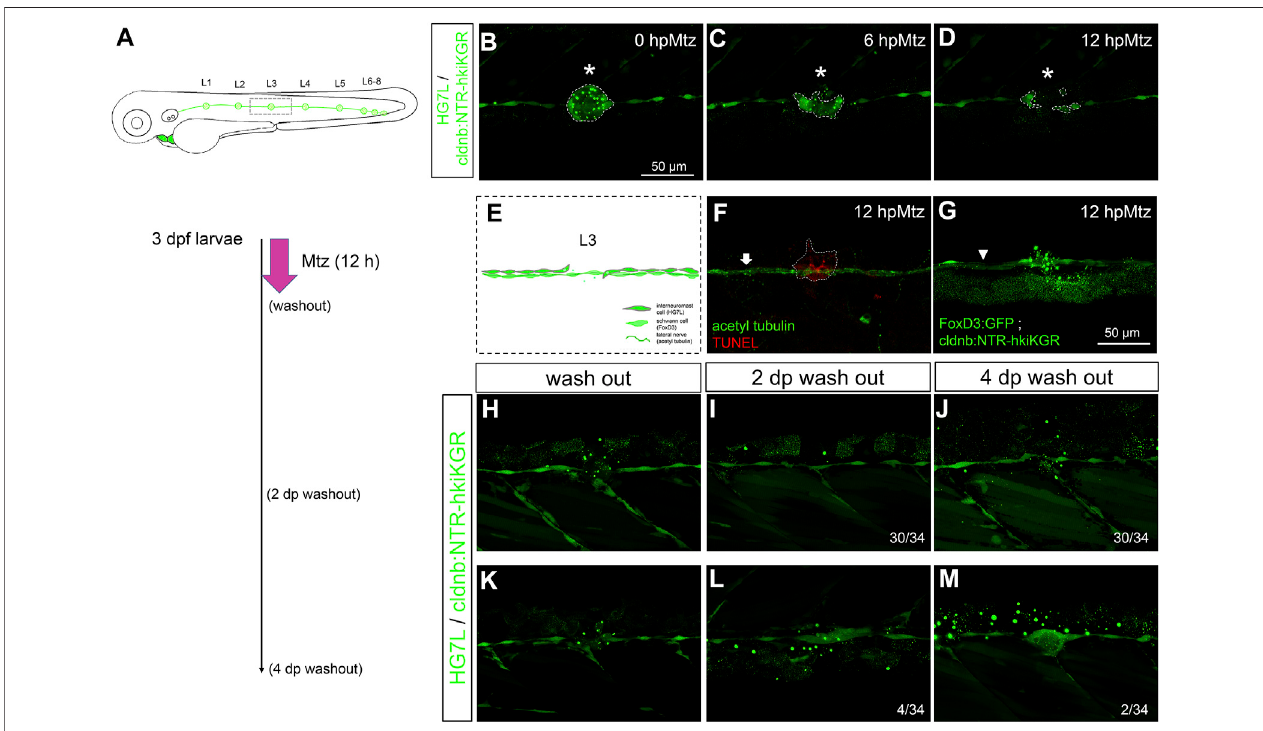
FIGURE 5 | Chemical-genetic ablation of neuromasts blocks neuromast regeneration in most but not all larvae. (A) Larvae from the cross of Et(HG7L) (green) and Tg( − 8.0cldnb:NTR-hkiKGR) (green dots) were treated with 2 mM metronidazole (Mtz) ob 3 days post-fertilization (dpf) for 12 h, washed out, cultured, examined, and photographed at designated h post-Mtz treatment (hpMtz) as shown in a series of cartoons. (B – D) Representative stacked images show decreasing size (enclosed by dashed lines) of neuromast (asterisks) during Mtz treatment. (E) A cartoon shows the absence of neuromast with undamaged Schwann cells and lateral nerve. (F) The TUNEL staining clearly labeled apoptotic cells in the Mtz-treated larva, and the lateral nerve (arrow) stayed undamaged. (G) Mtz was used to treat larvae from the cross of Tg(foxD3:GFP) and Tg( − 8.0cldnb: NTR-hkiKGR) .Inarepresentative stackedimage,Schwanncells (arrowhead pointed greenrod)appearedintactcompared to the disintegrating neuromast (asterisk). The faint broad green signal underneath is stacked signals from underlying tissues. (H – J) After washing out Mtz, most of the interneuromast cells (30/34) in the proximity of ablated neuromasts did not form a new neuromast. (K – M) A few (2/34) larvae had regenerated a neuromast (M) through cluster formation (4/34) (L) . Scale bars are the same in all panels but are only shown in (B) .